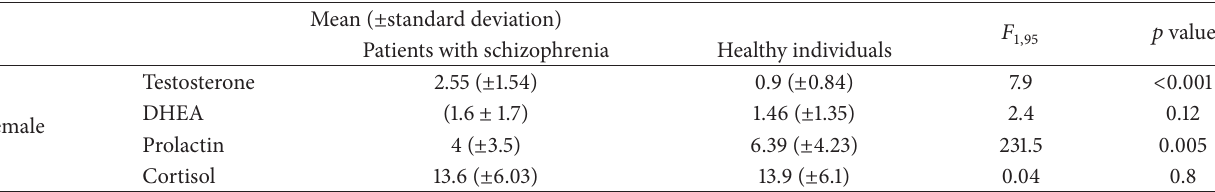
Table 2: Comparison using multivariate analysis of variance (MANOVA) of serum hormones levels in women with schizophrenia disorder and healthy women.